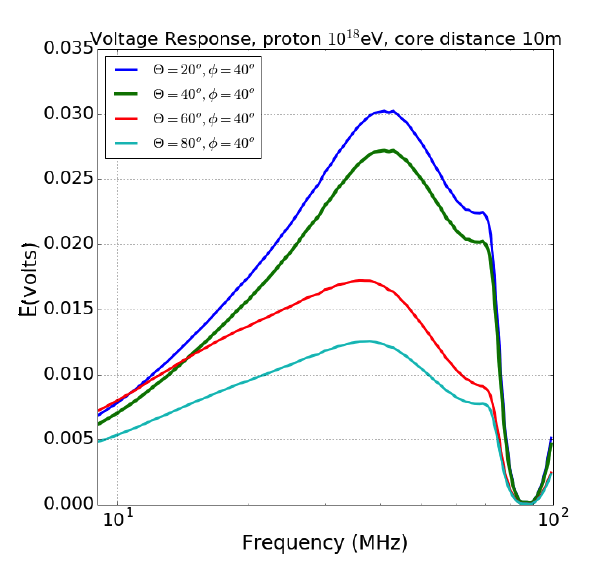
Figure 6. Butterfly Antenna voltage response model for EW pole for a shower generated by SELFAS. The proton’s energy is 10 18 eV and the distance between the shower core and the antenna is 10 m . The arrival directions are θ = 20 o ,φ = 40 o (blue), θ = 40 o ,φ = 40 o (green), θ = 60 o ,φ = 40 o (red), θ = 80 o ,φ = 40 o (light